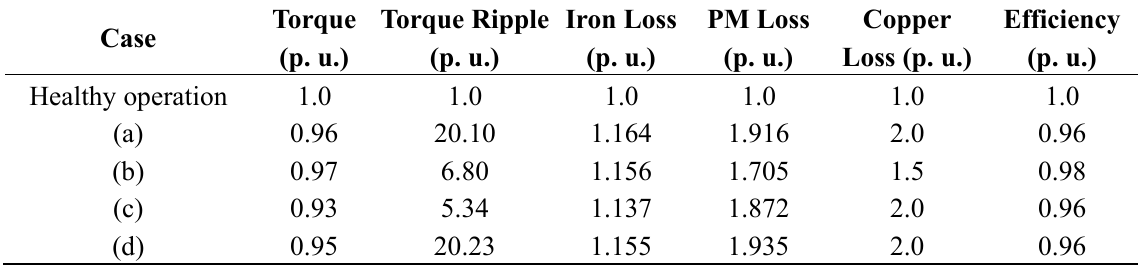
Table 9. performance comparison in fault-tolerant control modes using per unit value.